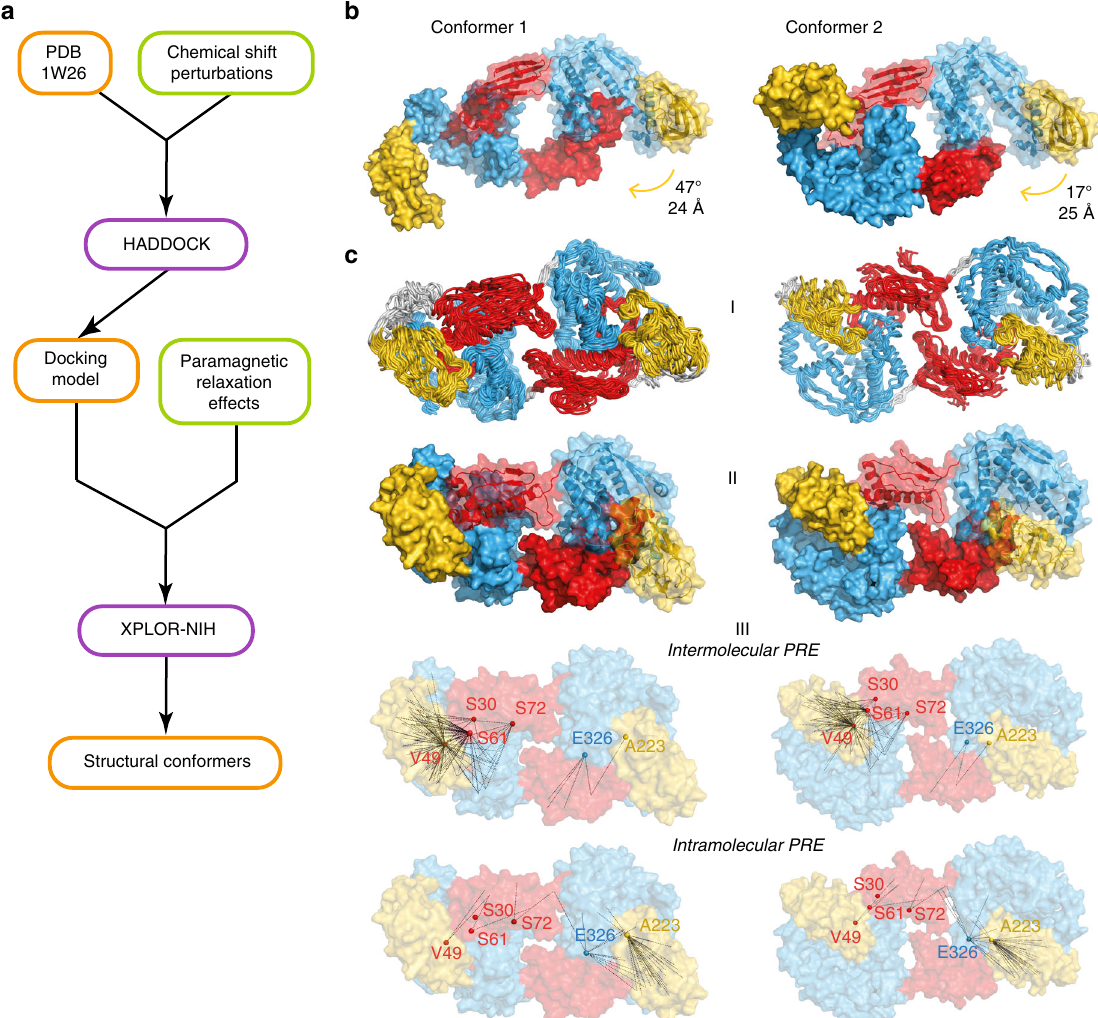
Fig. 5 Structure of the TF dimer in solution. a Flowchart for structural model determination of TF dimer. Structural models are indicated in orange boxes. Experimental data contributions are indicated in green boxes. Software packages are identi fi ed in purple boxes. b Lowest energy structures from the two clusters obtained with HADDOCK docking based on chemical shift perturbation data. Both monomers are represented in surface view, and one of them is semi-transparent to show the backbone. c XPLOR-NIH results represented as ( I ) ensemble of the 10 lowest energy structures with the fl exible residue segments in gray, ( II ) lowest energy structures with both monomers represented in surface view, one of them depicted semi-transparent to show the backbone, and ( III ) lowest energy structures in surface representation with experimental PRE distances represented, intermolecular (A – B, top) and intramolecular (A – A,